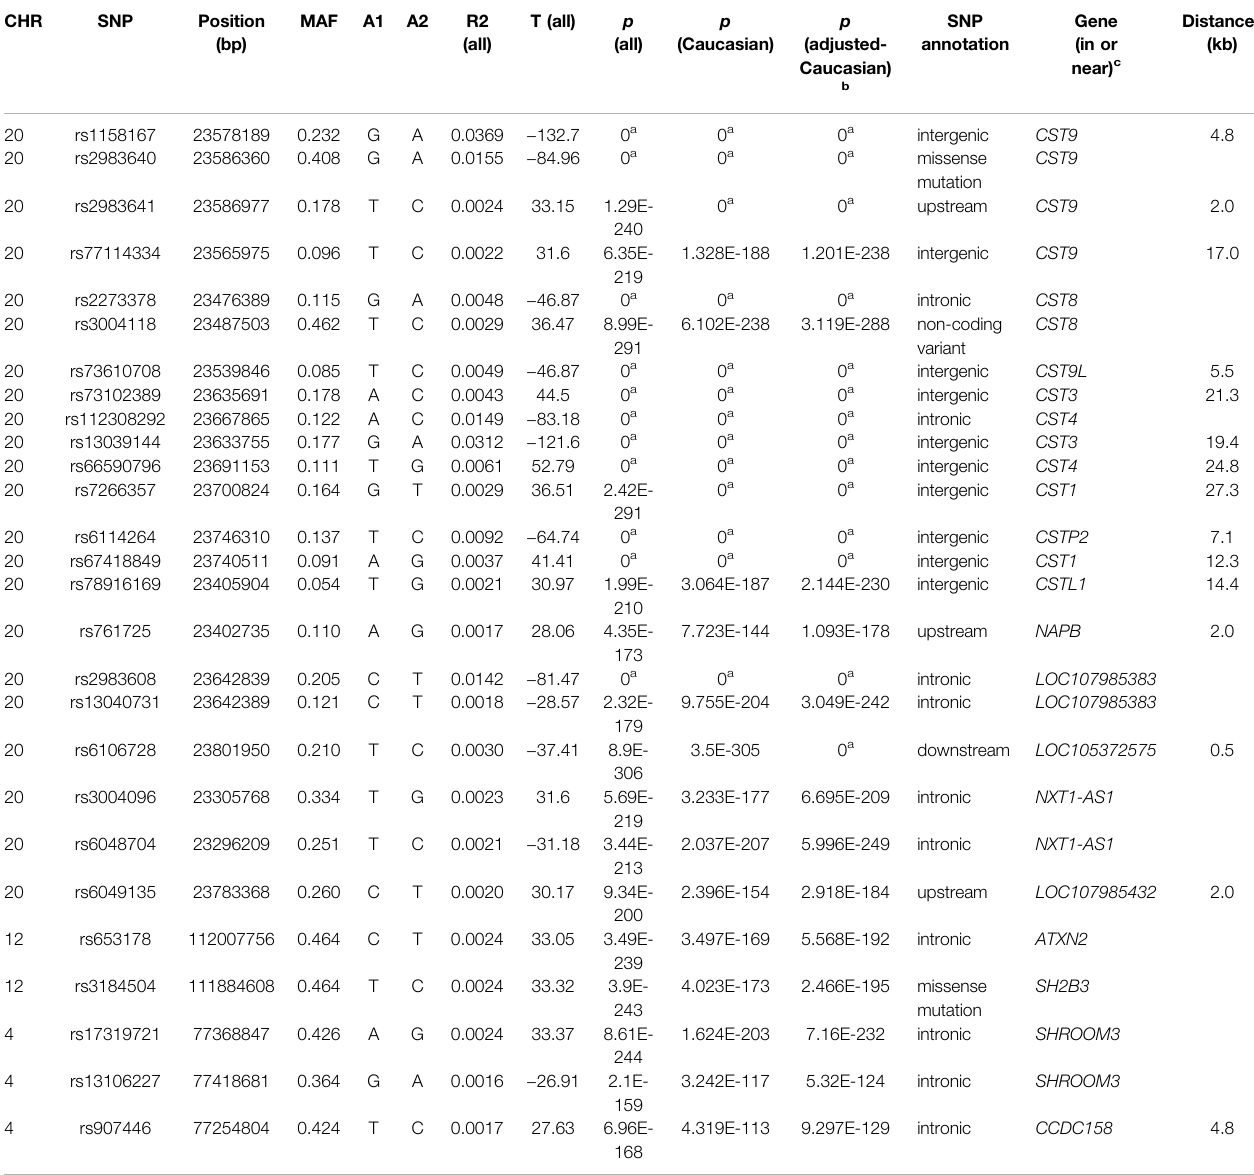
TABLE 1 | Genome-wide association study for plasma cystatin C ( P < 1 × 10 − 150